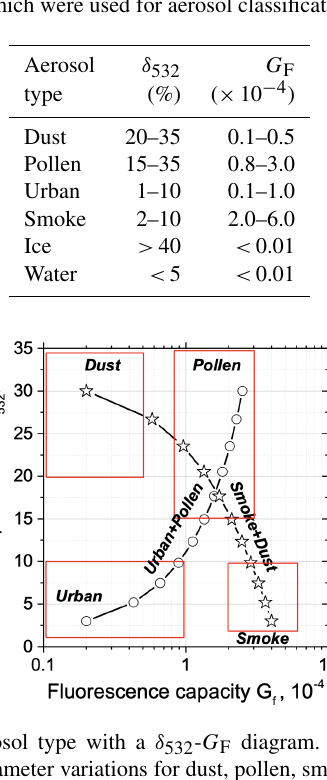
Table 1. Ranges of particle depolarization δ 532 and fluorescence capacity G F , which were used for aerosol classification.